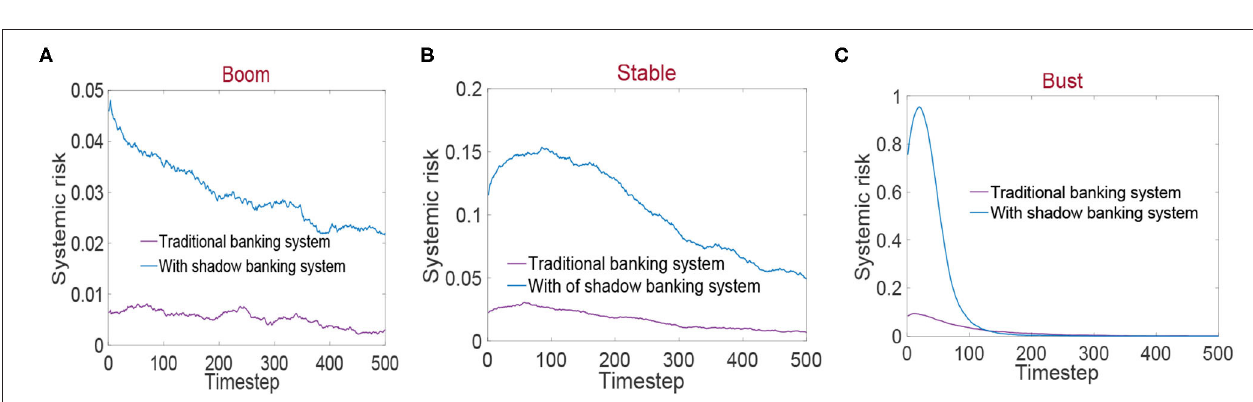
FIGURE 4 | (A–C) Representation of the systemic risk changes in the banking systems under the macroeconomic